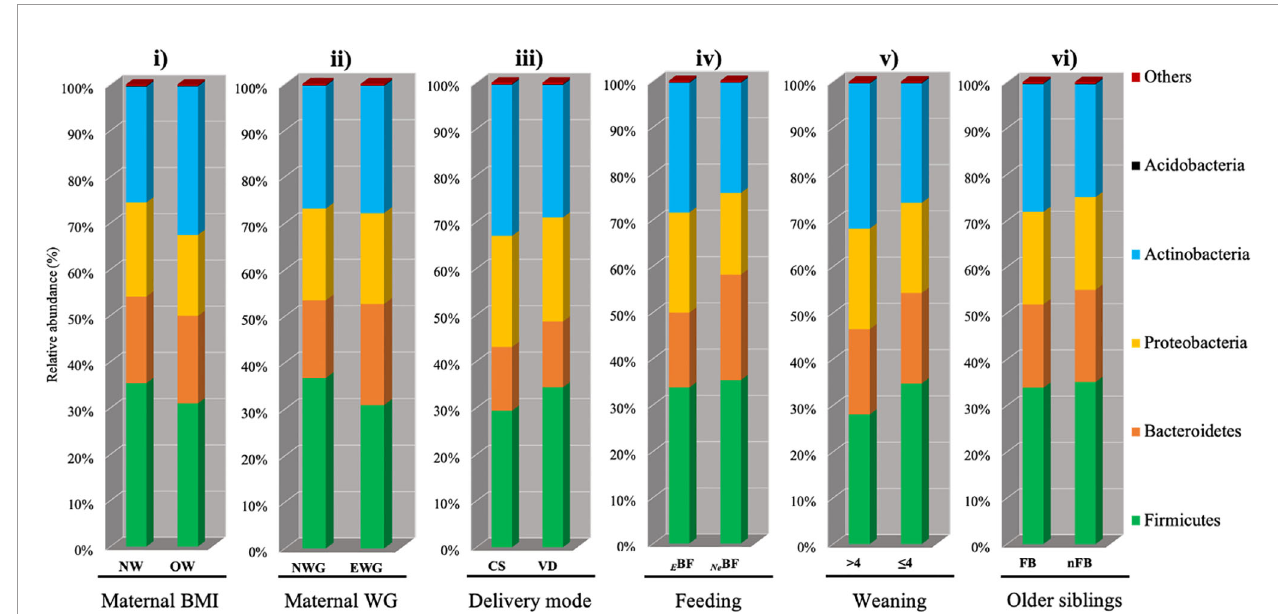
FIGURE 2 | In fl uence of different factors on early microbiota composition at the phylum level (16S rRNA gene amplicon sequencing) in T2 fecal samples (infants at 6 months of age). Starting from the left: i) and ii) Maternal factors: maternal pre-pregnancy body mass index (BMI) and gestational weight gain (WG), respectively. NW [n.37] : normal pre-pregnancy BMI (BMI < 25 kg/m 2 ), OW [n.12] : excessive pre-pregnancy BMI (BMI ≥ 25 kg/m 2 ); EWG [n.20] : excessive gestational WG, NWG [n.29] : optimal gestational WG). iii) Delivery mode (CS [n.7] : caesarean section, VD [n.46] : vaginal delivery). iv) Feeding ( E BF [n.31] : exclusive breast-feeding, NeBF [n.21] : not exclusively breast fed, mixed fed or exclusively formula fed). v) Weaning ( ≤ 4 [n.41] : before 4 months of age, >4 [n.9 : after 4 months of age). vi) Presence of older siblings (FB [n.30] : fi rst-born, nFB [n.22] : not fi